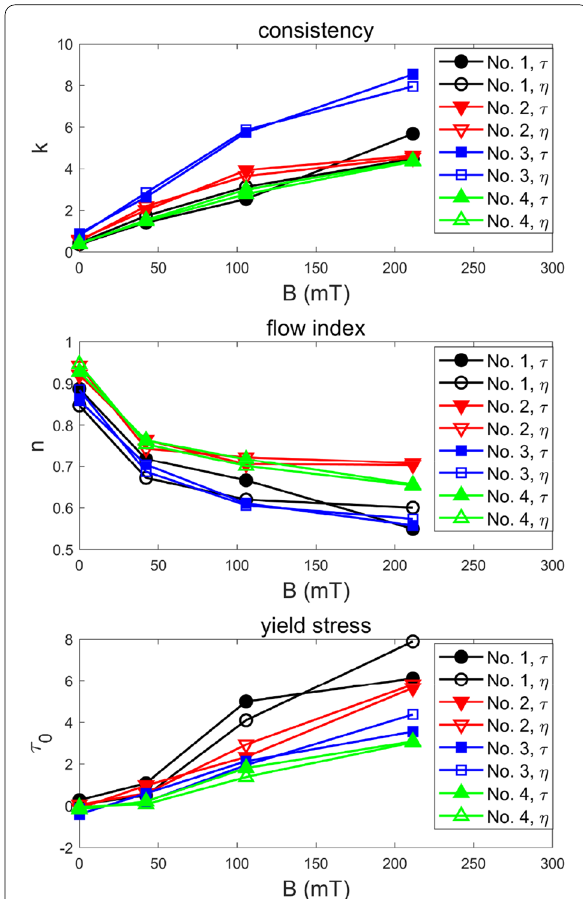
Figure 5 Fitting parameters (solid marks represent fitting results from τ − ˙ γ relationship and hollow marks represent fitting results from η − ˙ γ